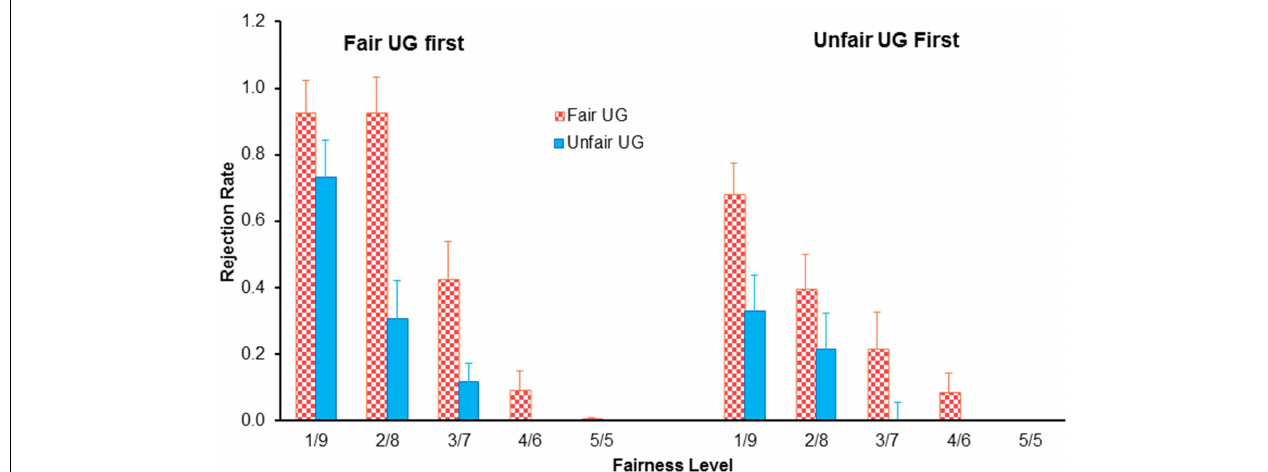
FIGURE 2 | The reject rate as a function of type of offers, experimental block, and the order of block in the ultimatum game. Bars indicate standard error.